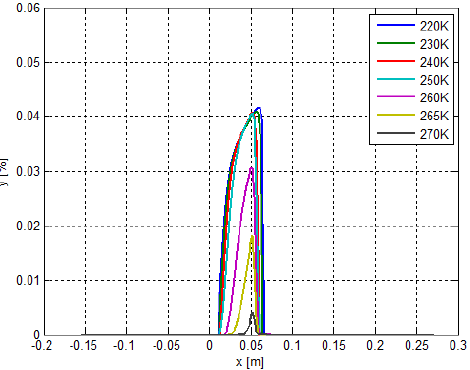
Figure 14. Humidity distribution curves along the axial cross-section of the supersonic separator at temperatures 220, 230, 240, 250, 260, 265, and 270 K. temperatures 220, 230, 240, 250, 260, 265, and 270